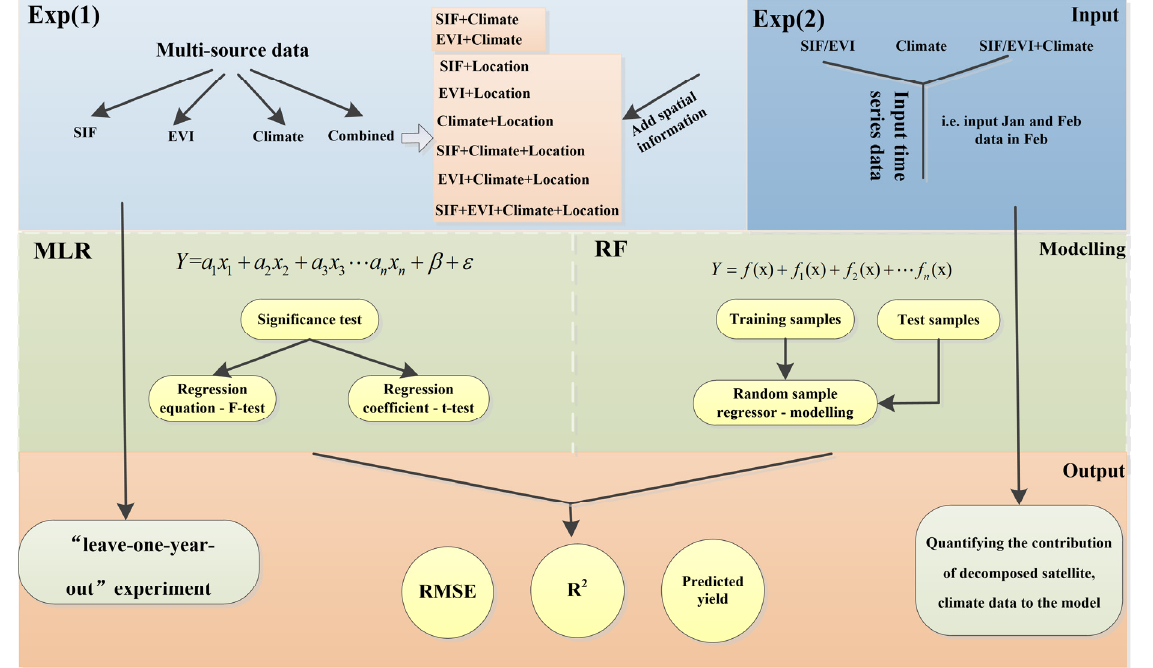
Figure 2. Experimental flow chart (Related parameter description: Location represents spatial information, including latitude and longitude; a 1 . . . a n represent partial regression coefficient; β is a random variable and a constant term; ε represents random error; Jan is short for January; Feb is short for February).